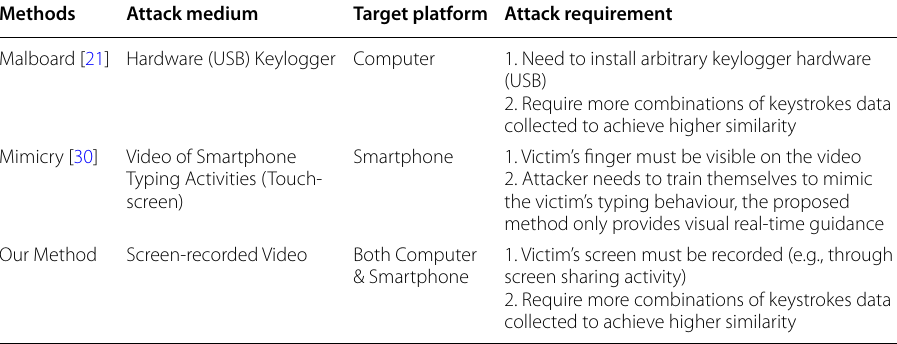
Table 9 Attack specification of some keystroke dynamics spoofing methods